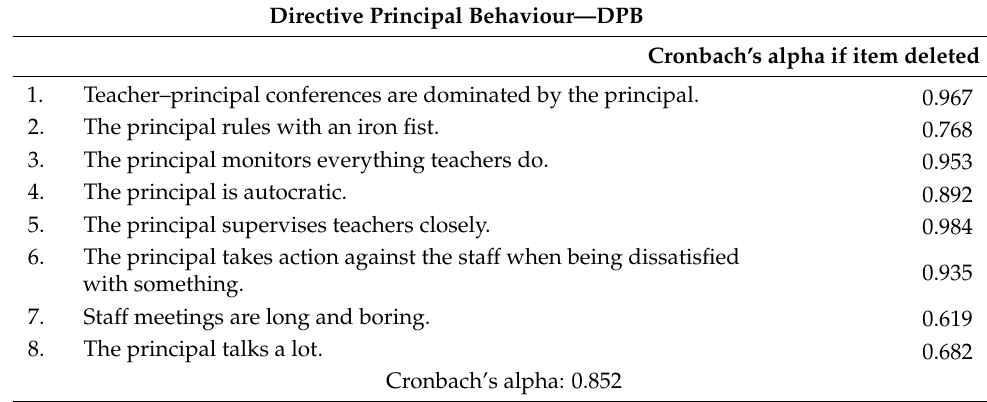
Table 4. Directive principal behaviour DPB—Cronbach’s alpha for internal consistency.